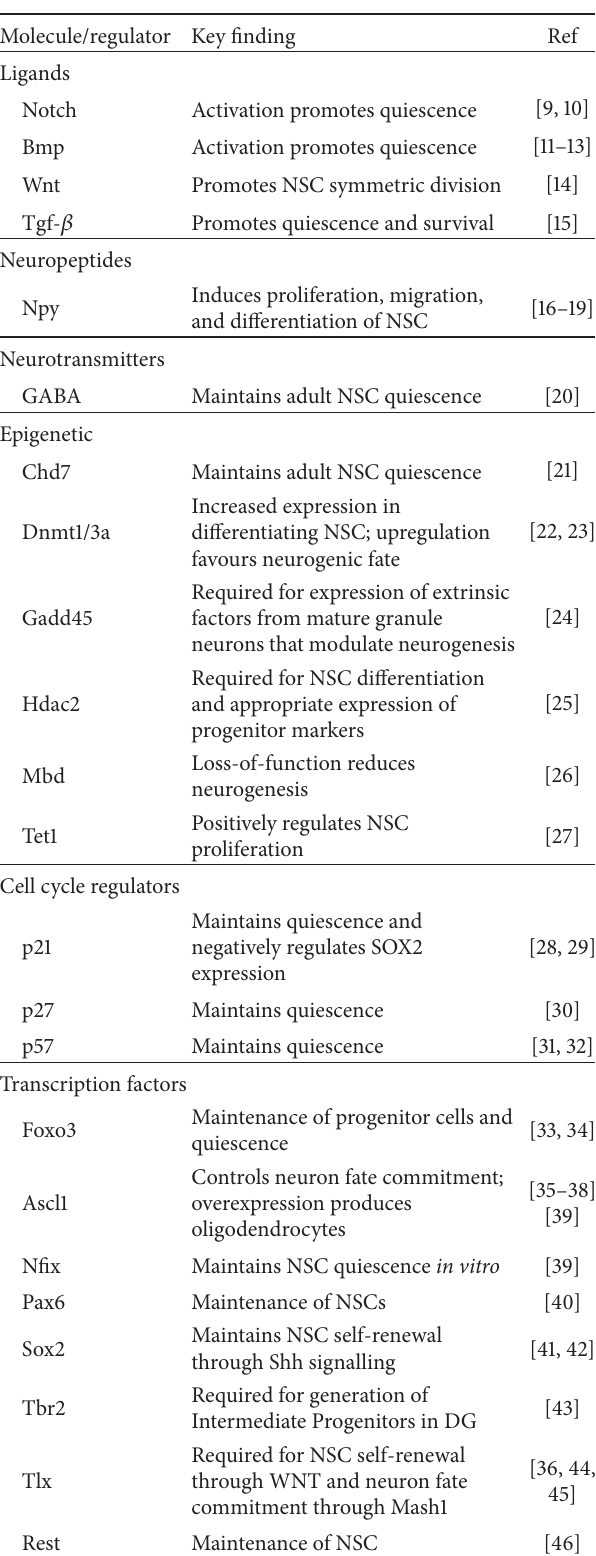
Table 1: Molecular regulators of NSC in adult SGZ and SVZ. Summary of molecular regulators of adult NSC, grouped into ligands, neuropeptides, neurotransmitters, epigenetic, cell cycle regulators, and transcription